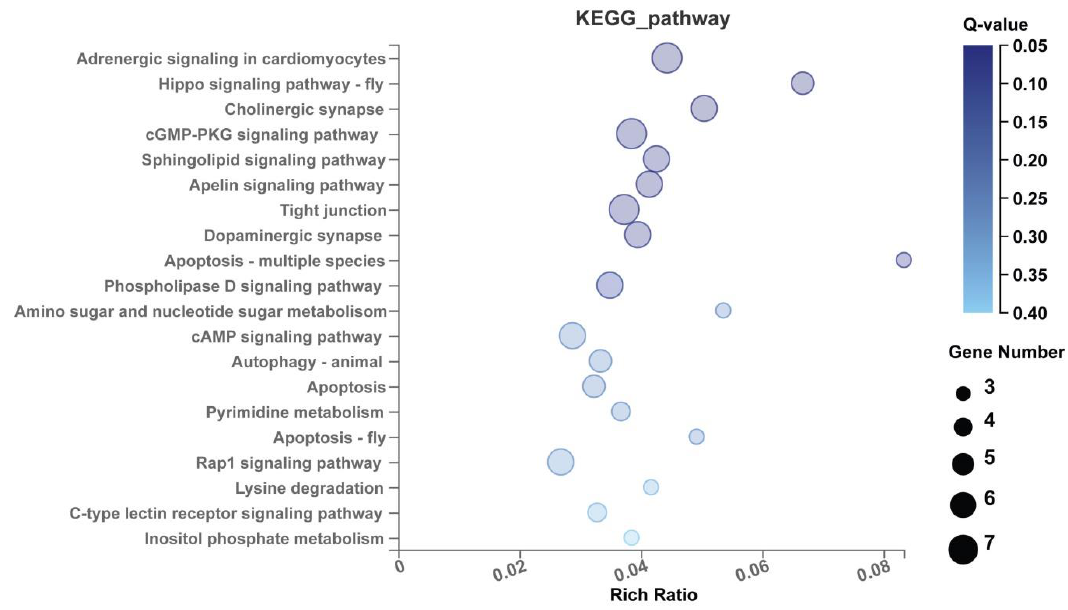
Figure 10. A bubble result graph of KEGG aggregation for the target genes of the 12 stably enriched DEmiRs. It is clear that the 12 stably enriched DEmiRs significantly functioned in “adrenergic signaling in cardiomyocytes (Q = 0.05).